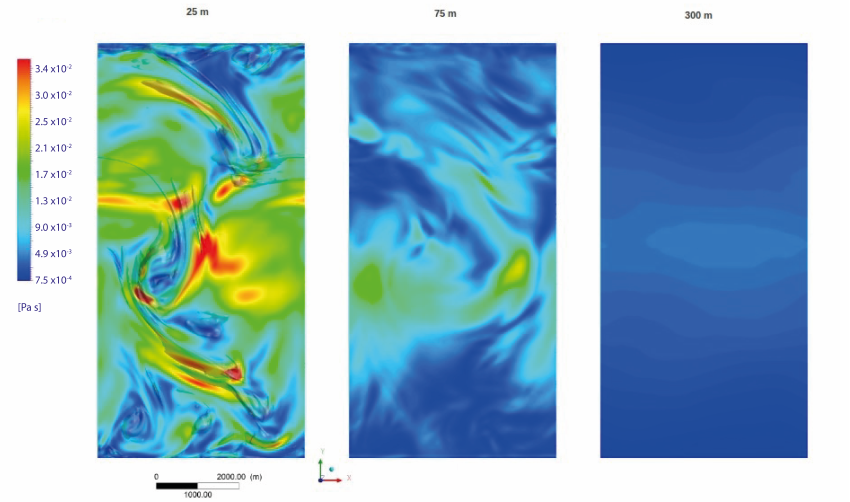
Figure 8. The subgrid momentum diffusion distribution at the depths of 25 m ( left ), 75 m ( middle ), and 300 m ( right ).The Ro = 1 isosurface projection is shown as a grey region. The difference from the gradient wind balance was computed and plotted in Figure 9.